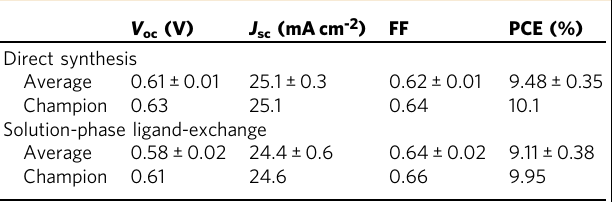
Table 1 Photovoltaic parameters of devices based